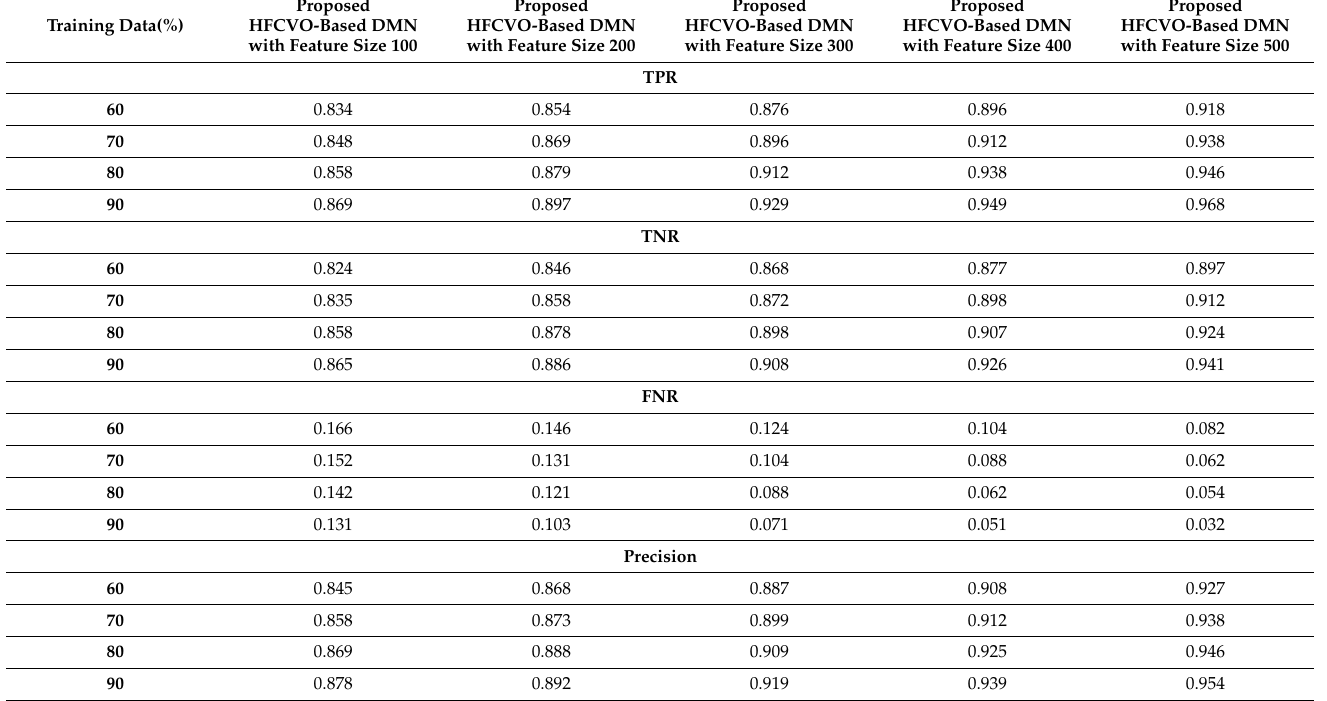
Table 4. Performance analysis using Real-time dataset for TPR, TNR, FNR, precision, and testing